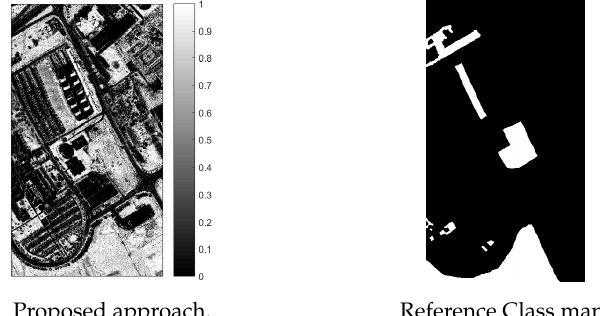
Figure 26. Comparison of Meadows and Bare Soil abundance and binary reference map for